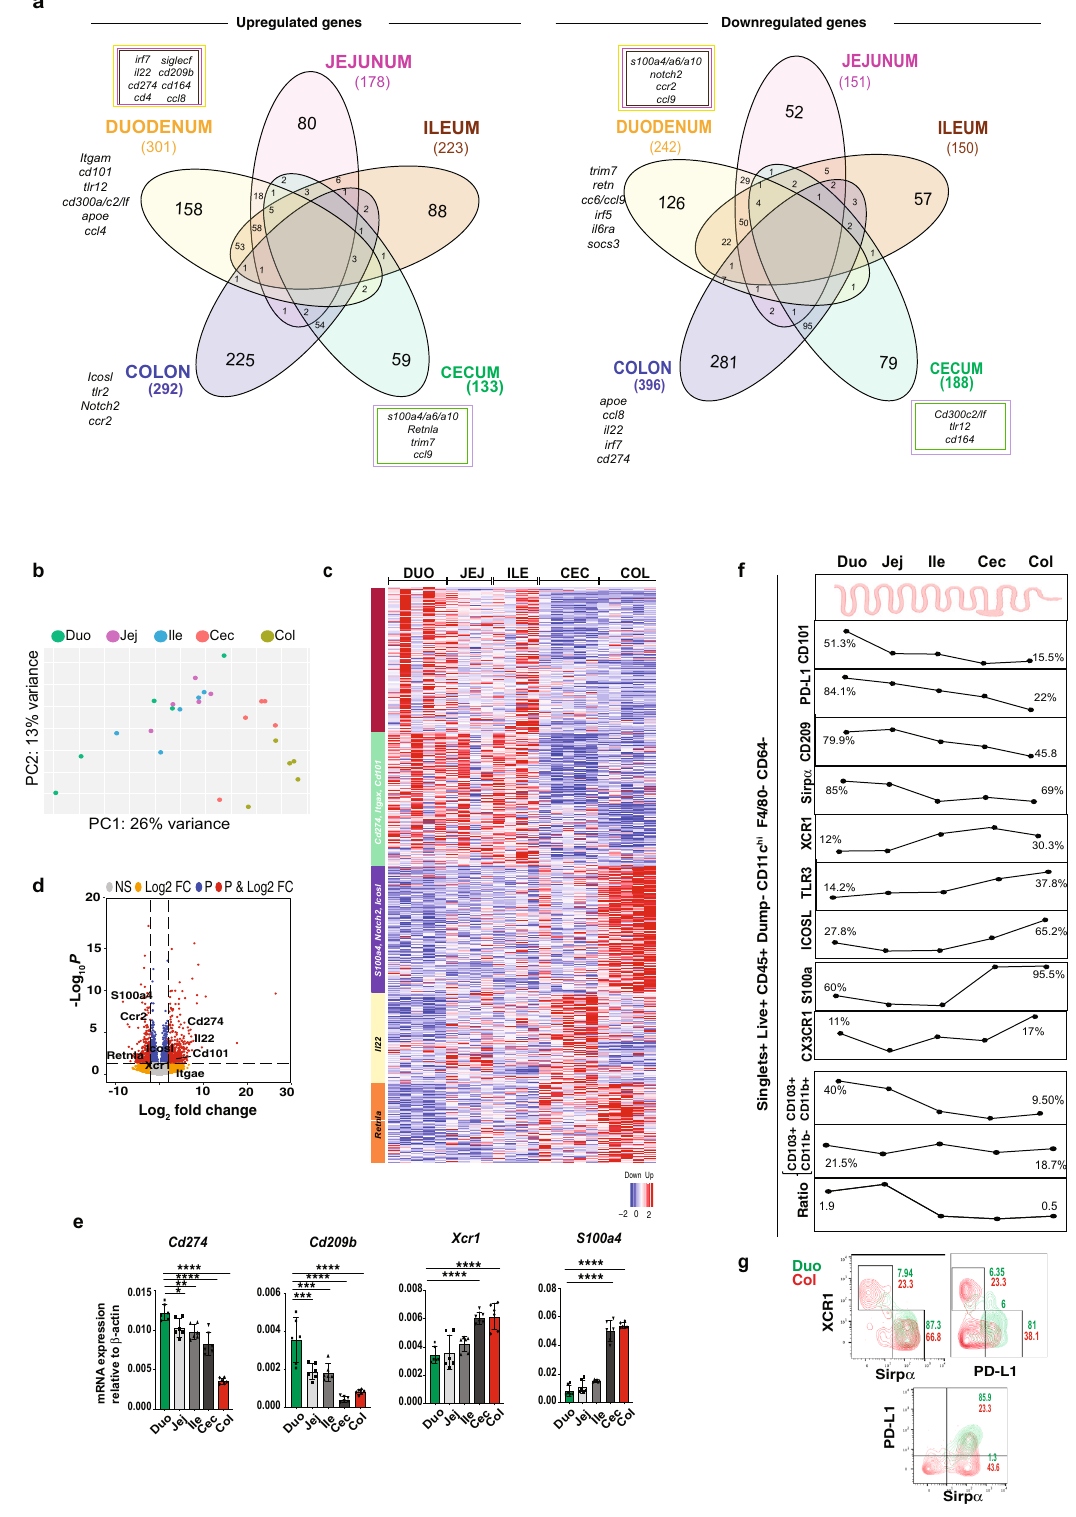
22, IL-17A, IL-17F, IFN- γ , and IL-10 from cultures with colonic T-cell responses. We cultured DCs from the uSI (duodenum and DCs. No difference between uSI vs colon was observed for IL-4 proximal jejunum) or the distal colon with OT-II naive T cells and IL-6 (Fig. 3a). To investigate whether cytokine production (1:20 ratio) in the presence of ovalbumin (OVA) for 7 days and was associated with T-cell differentiation, we sorted post-cultured measured cytokine production and T-cell differentiation by fl ow T cells and performed qPCR analysis of Ifng , Tnf , Il6, and Il10 . cytometry. We found increased production of IL-13 and TNF in We found that Ifng mRNA was upregulated in re-sorted T cells supernatants from cultures with uSI DCs and higher levels of IL- NATURE COMMUNICATIONS| (2021) 12:4907